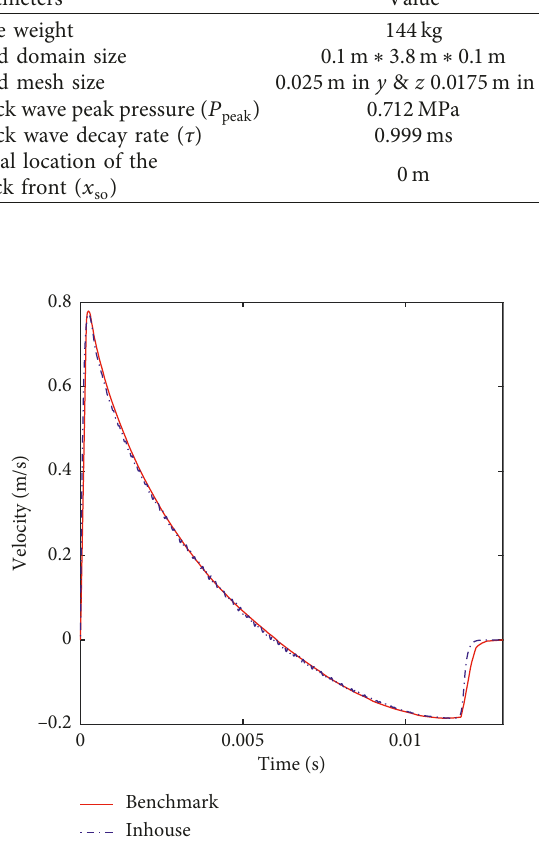
Figure 6: Comparison of structural response of the in-house solver and benchmark solution (13ms).